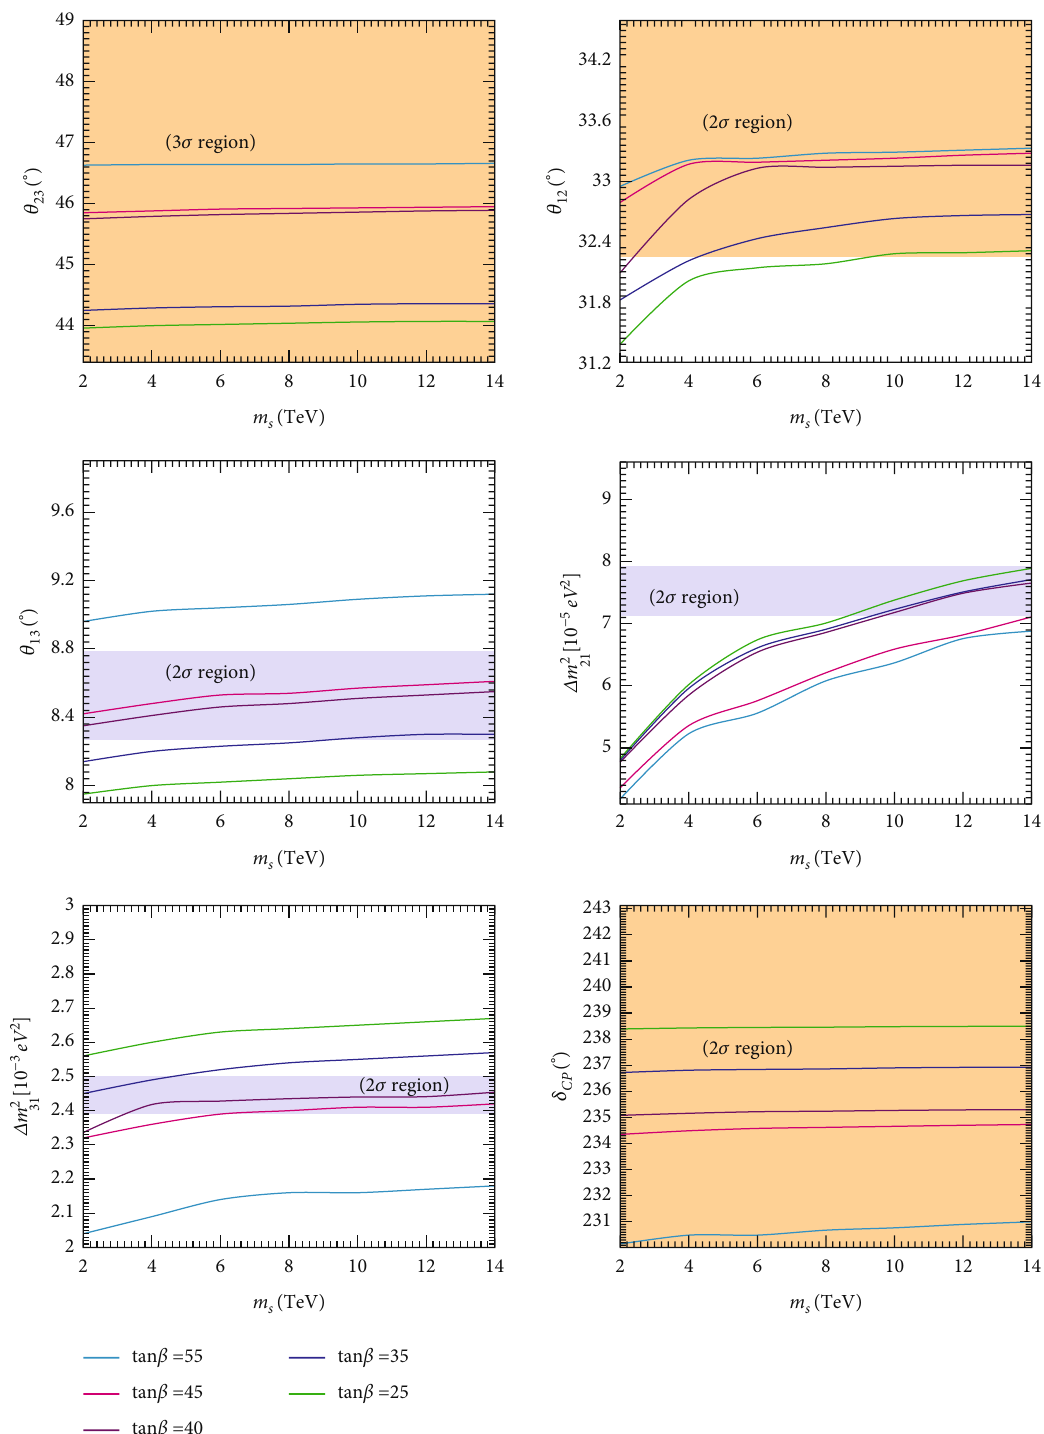
j , and δ , j Δ m 2 with variation of m CP ij ij